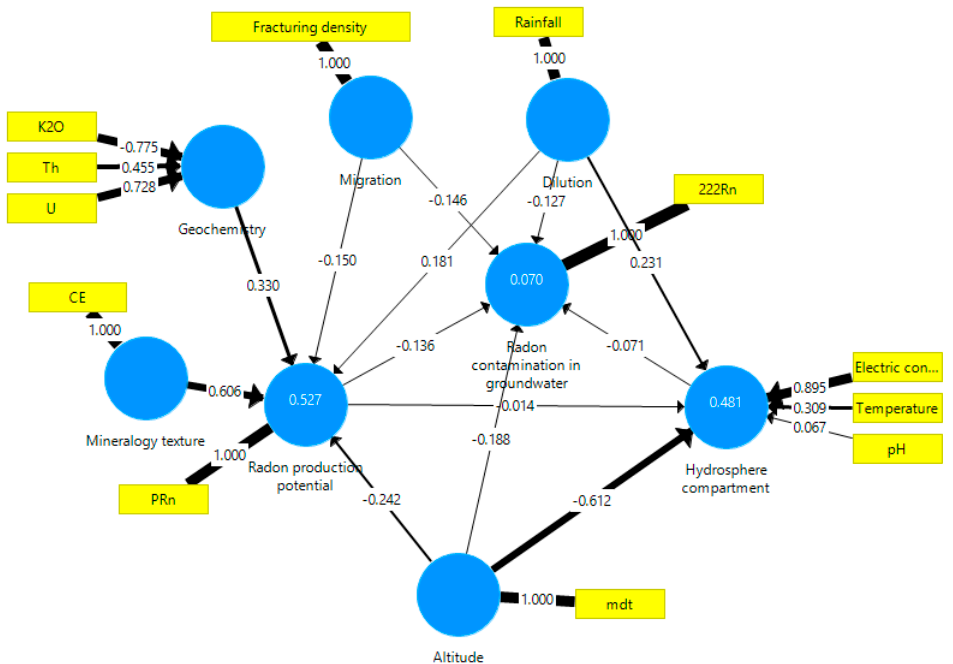
Figure 9. Diagrammatic representation of PLS-PM complete models for cluster C2 composed by di ff erent groups of rocks from the studied region.